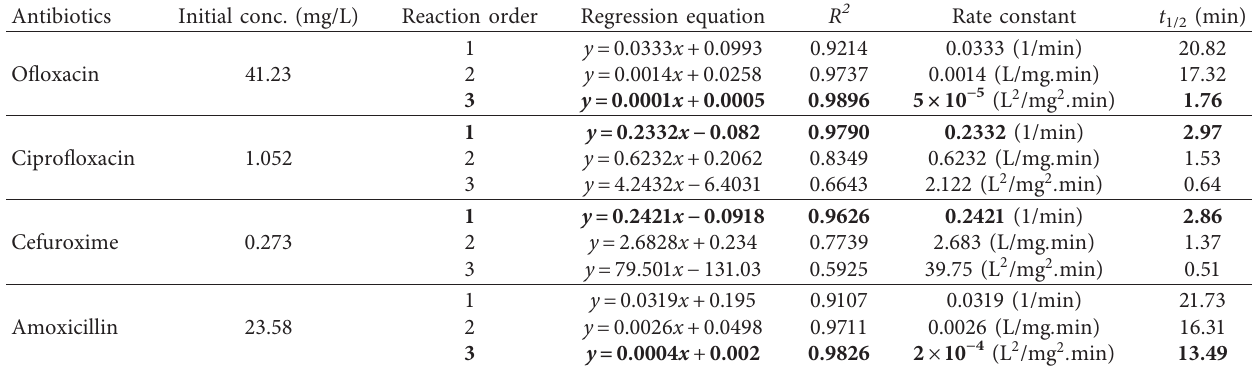
Figure 7: Effect of the reaction time on the formation of (a) O Table 1: Reaction kinetics models for the decomposition of four antibiotics.